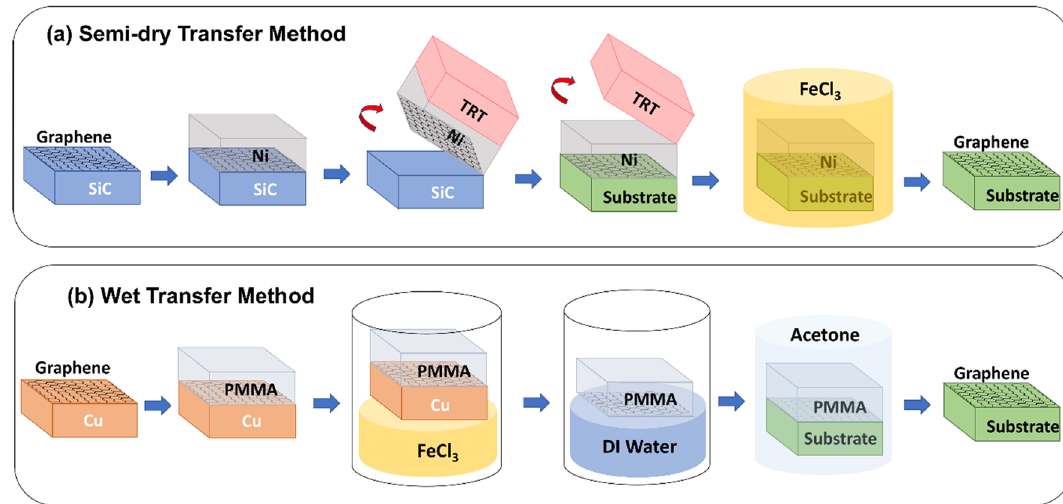
Fig. 2 The schematic illustration of graphene transfer methods. a Semi‑dry transfer method, b Wet transfer